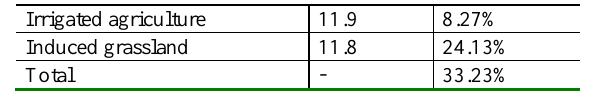
Table 4. Non-forest categories with PTC values higher than 10 and their coverage in percentage by visual